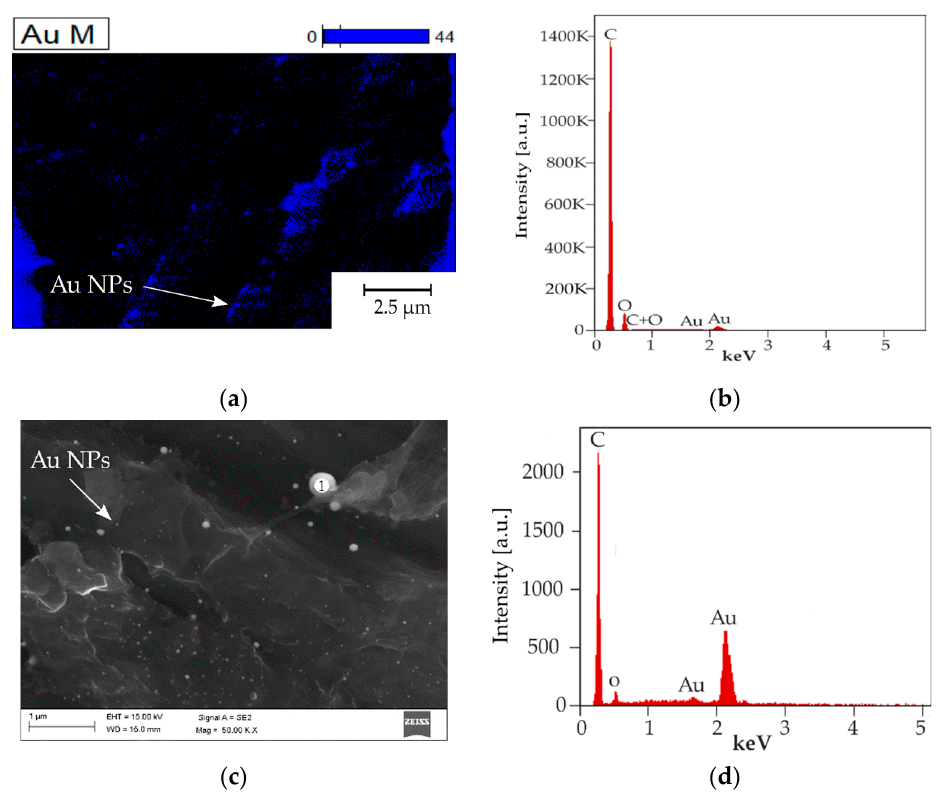
Figure 5. EDS qualitative chemical elements distribution map and X-ray energy dispersion spec- trum: ( a ) Au distribution map—Au marked as blue; ( b ) EDS X-ray spectrum from Figure 5a area ( c ) SEM image with localisation of EDS measurement point 1 ( d ) EDS X-ray spectrum from point 1 from Figure 5c.